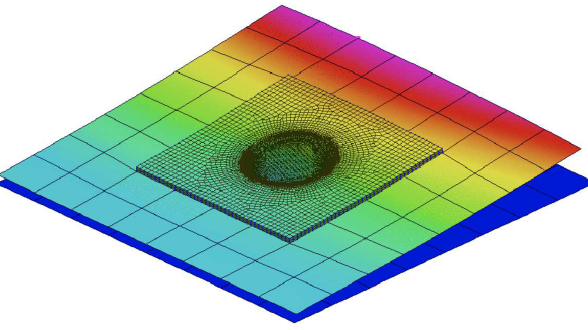
Fig. 1. Spot-weld 3D